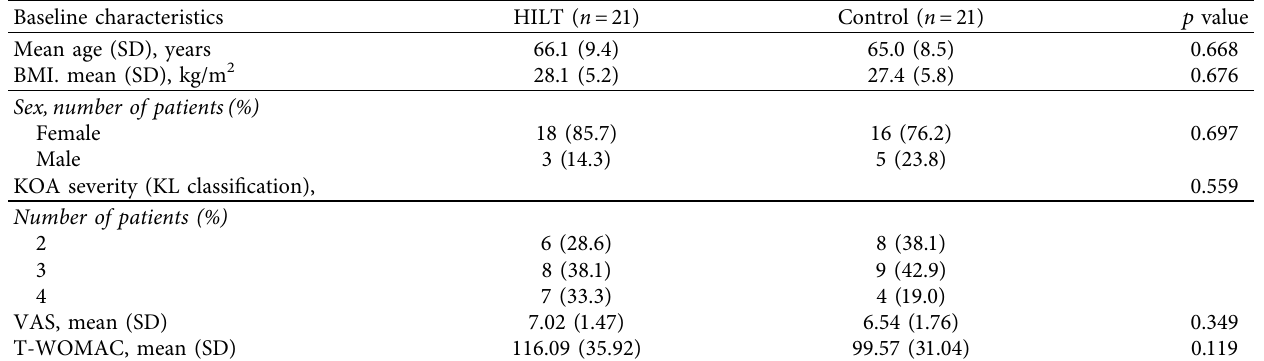
Table 1: Baseline demographic and clinical characteristics of the participants.